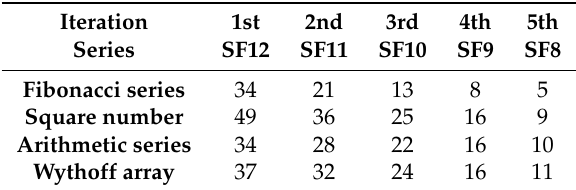
Table 2. K Cluster Values for K-Means